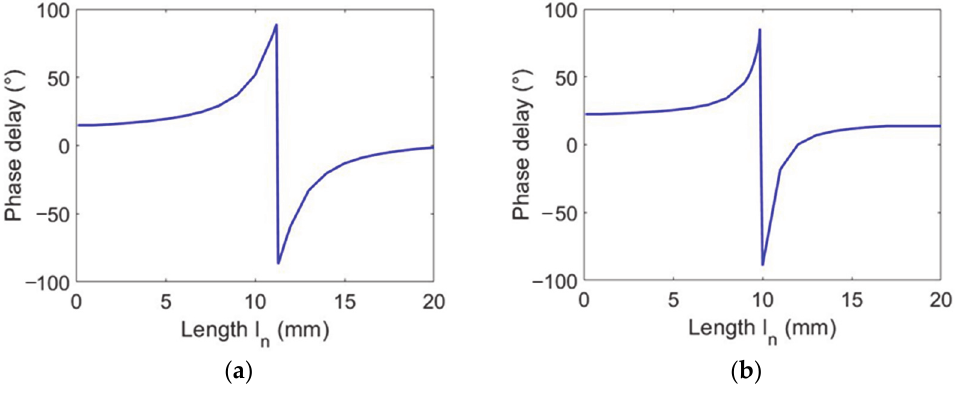
Figure 7. Phase delay graph: ( a ) 900 Hz; ( b ) 1000 Hz. Table 2. Design dimensions of the metasurface derived using phase delay.